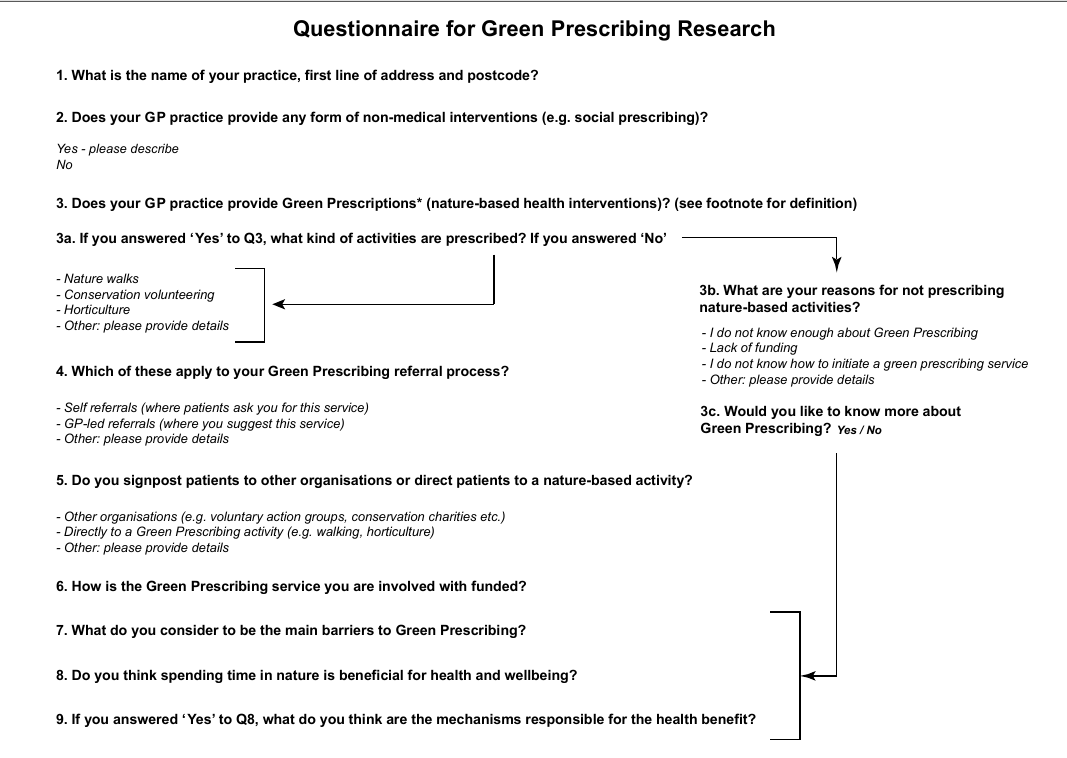
Figure A2. Green prescribing questionnaire for NBOs.